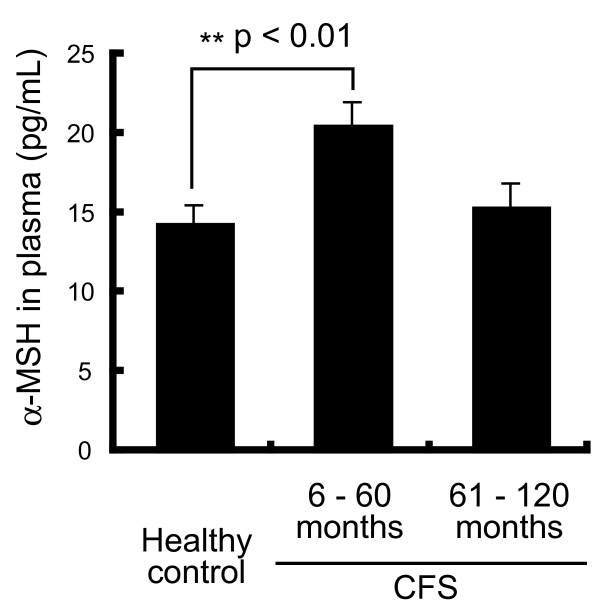
Concentrations of α-MSH in CFS patients divided according to duration of CFS and in healthy controls. The mean α-MSH level in the 6-60-month group was significantly higher than the levels in the other groups (p < 0.01 compared with the healthy group, p < 0.05 compared with the 61-120-month group). Values are given as means ± SEM.